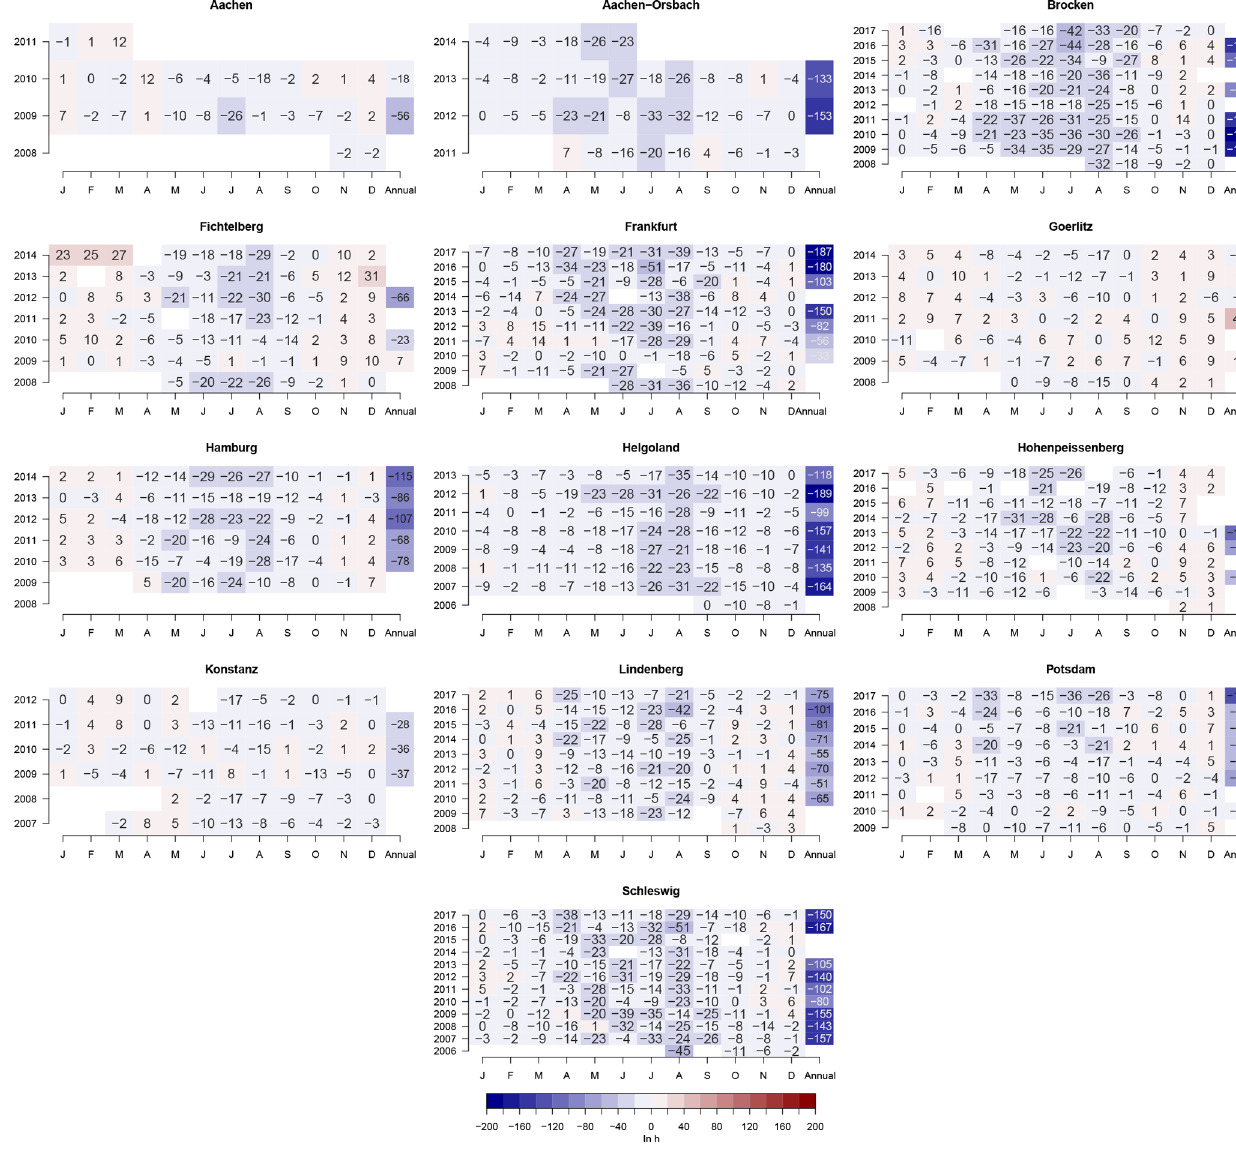
Figure 4. Monthly and annual differences of automatic and manual measurements in hours for each station. Negative values (blue) represent less sunshine duration recorded by automatic